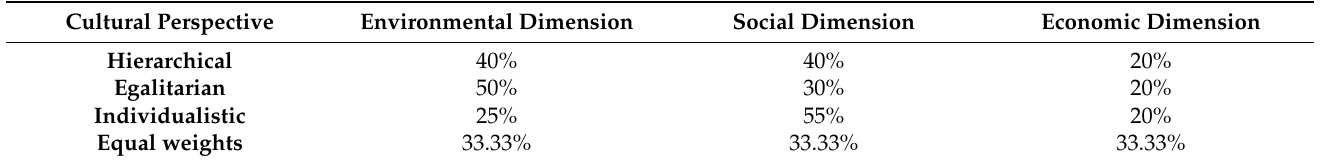
Table 8. Cultural perspective weights (adapted from [61]).